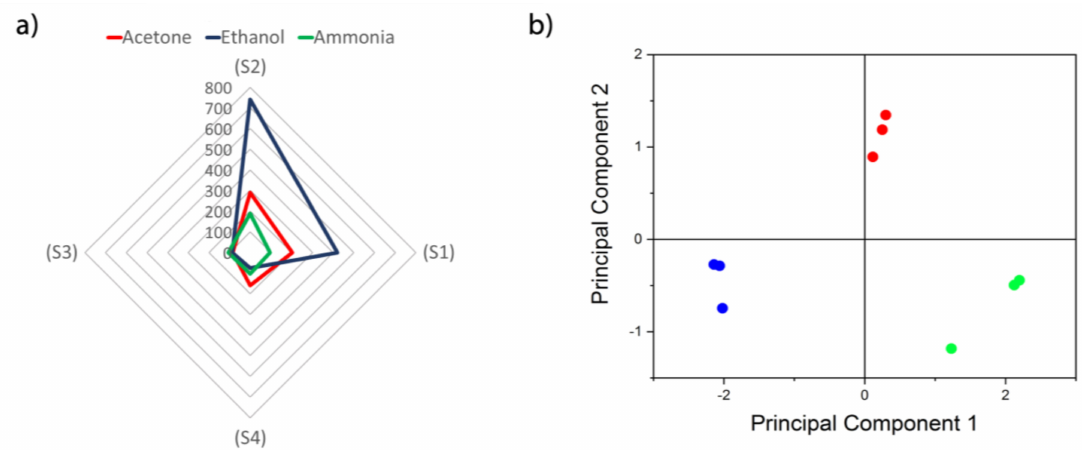
Figure 10. ( a ) Radial representation of the sensor array responses to 10 ppm of acetone, ethanol and ammonia. ( b ) Principal components analysis applied to data for discrimination of acetone (red), ethanol (blue) and ammonia